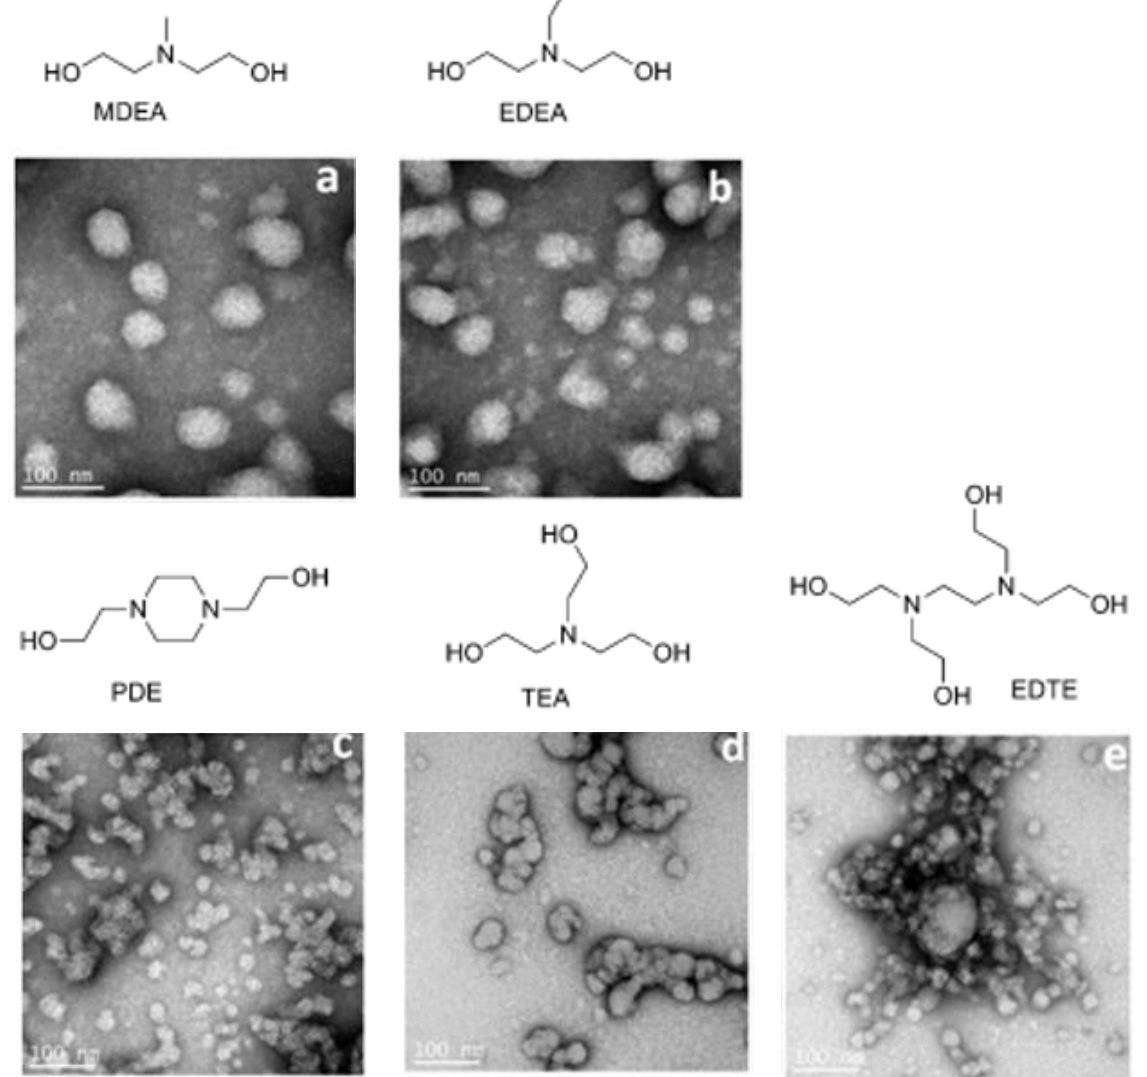
Figure 4. Structure of amino polyols used in the preparation of the polyurethane dispersions (PUDs) and their corresponding polyurethanes negative stained TEM images (all scale bars are 100 nm). The a , b , c , d , and e are related to the chemical structures of the amino diols on the top of each TEM image (adapted with permission from [71]).